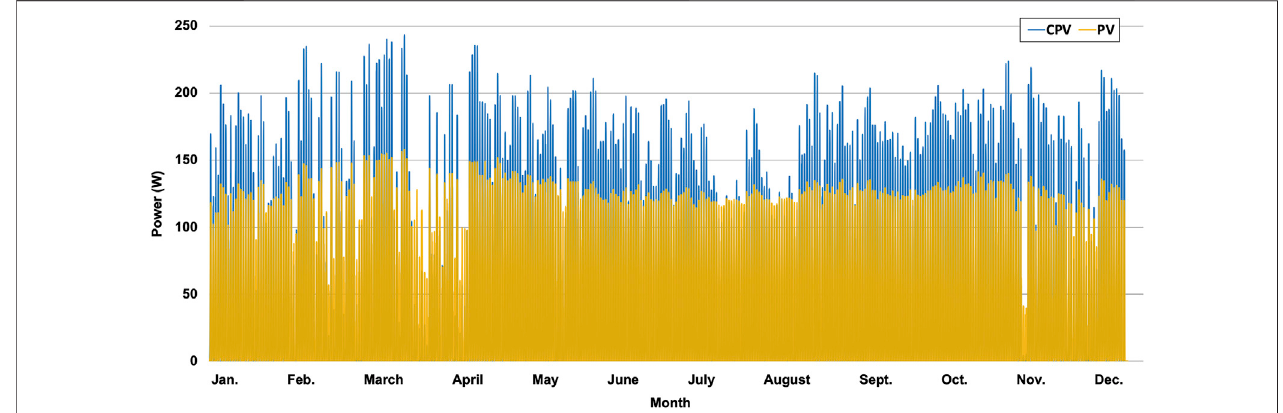
FIGURE 7 | Yearly trend of power generation for both